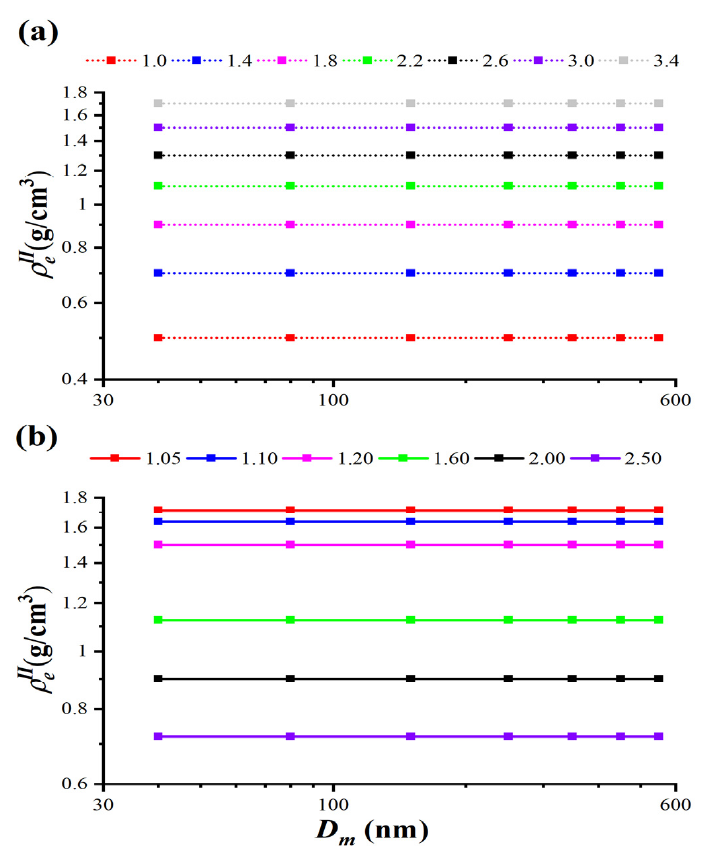
Figure 4. ( a ) The size-resolved ρ eII for the Y particles with ρ from 1.0 to 3.4 g/cm 3 , which are represented by the change in line color from red to grey; ( b ) The size-resolved ρ eII for the Z particles with a χ from 1.05 to 2.50, which are represented by the change in line color from red to purple. Table 2. The trends of ρ eI , ρ eII , and ρ eIII with size of aspherical particles as χ (a) and ρ (b) change. The Trend